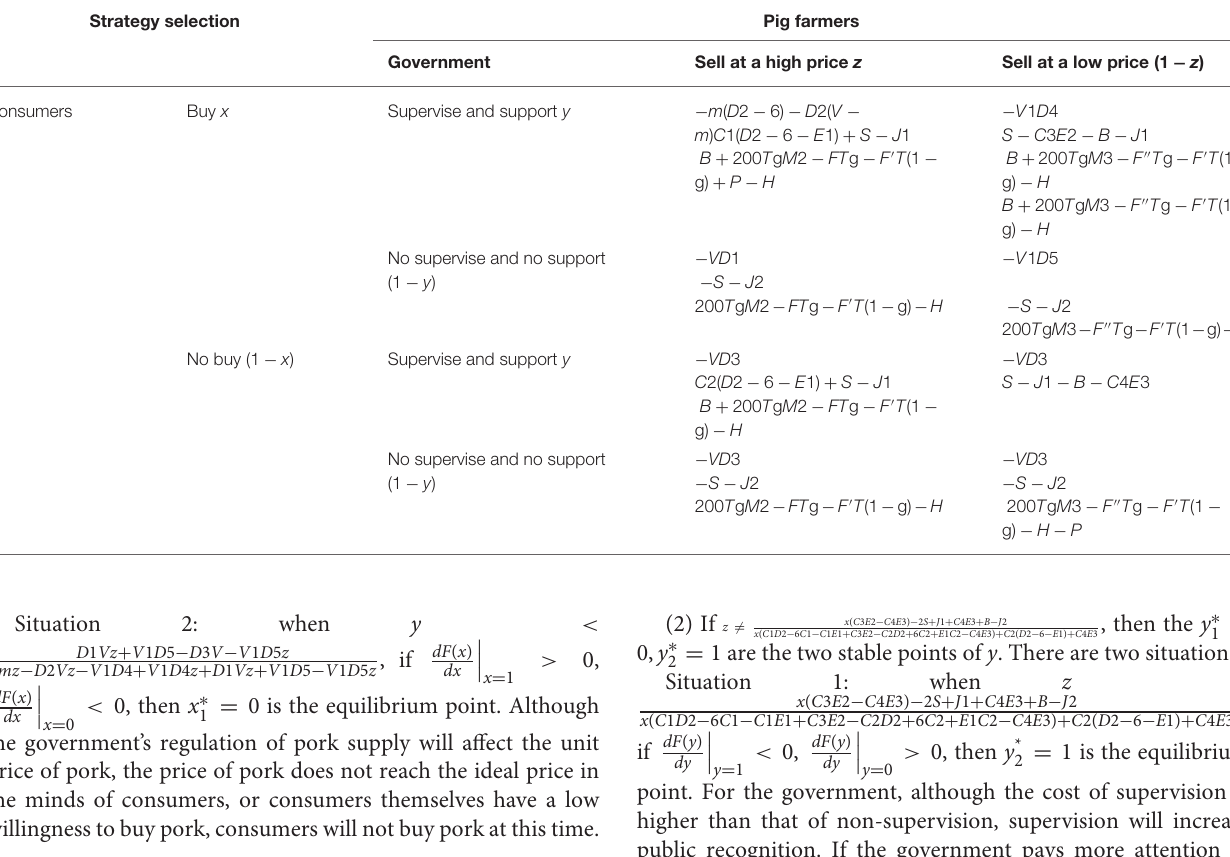
TABLE 2 | The payoff matrix. Strategy selection Pig